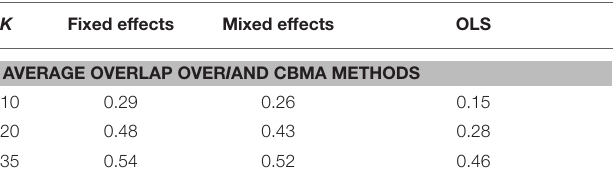
TABLE 2 | Averaged overlap values over the I folds and the CBMA methods (top) and over the I folds and the group level models (bottom) for each K .